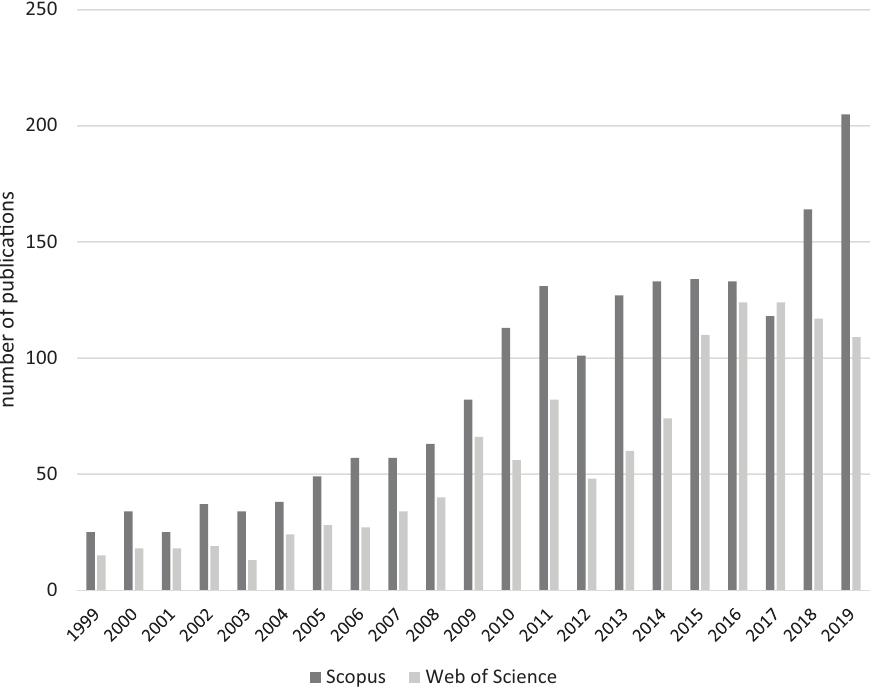
Figure 1. Number of scientific publications (articles, conference papers and book chapters) in the Scopus and Web of Science databases in 1999–2019 related to SERVQUAL (source: own elaboration based on data from the Scopus and Web of Science